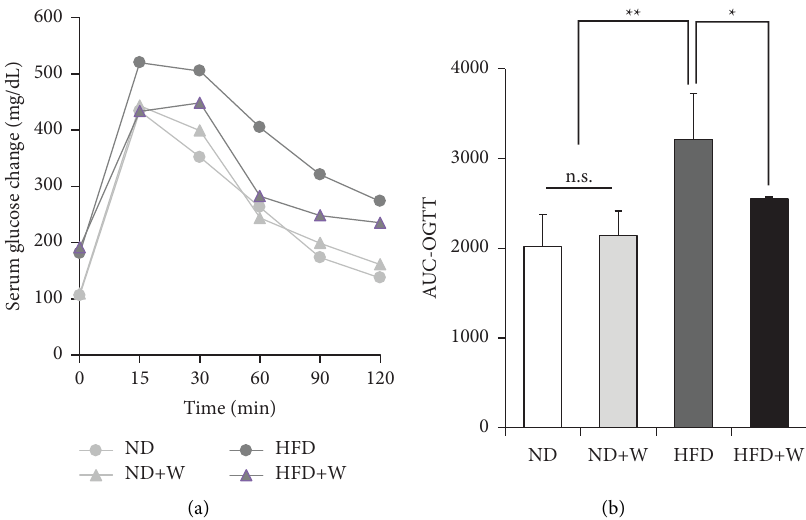
Figure 5: Comparison of serum blood glucose change in OGTT of mice taking experimental diet. Seven-week-old C57BL/6J mice were reared on experimental diets for 3 months. (a) Oral glucose tolerance test (OGTT, 2g/kg) at 0, 15, 30, 45, 60, 90, and 120min. (b) Te change in the area under the curve (AUC) value of the serum glucose in the mice during the OGTT. Data are presented as mean ± SD ( n � 4-5 per group). Te data were analyzed with one-way ANOVA combined with the Tukey test. ∗ p < 0 . 05; ∗∗ p < 0 . 01.